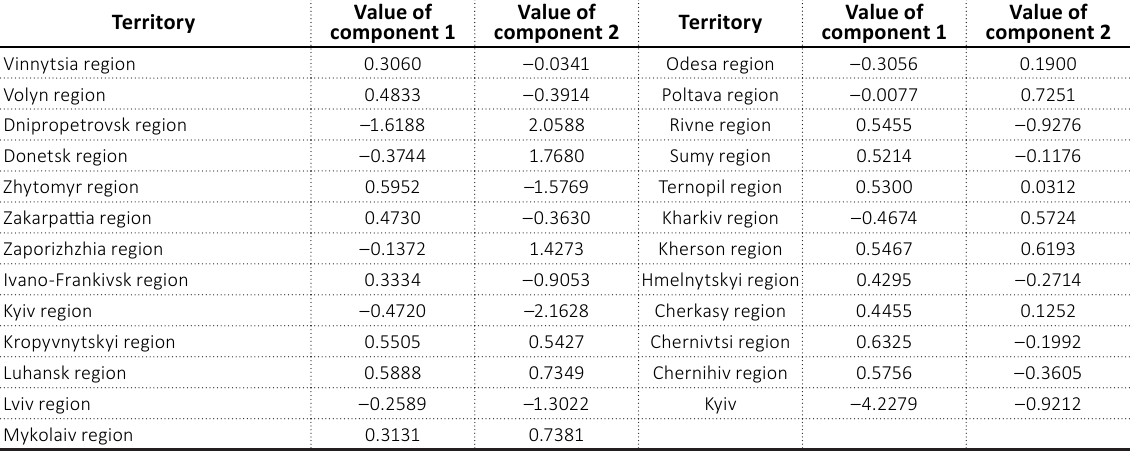
Table 9. The values of the major components for the regions of Ukraine